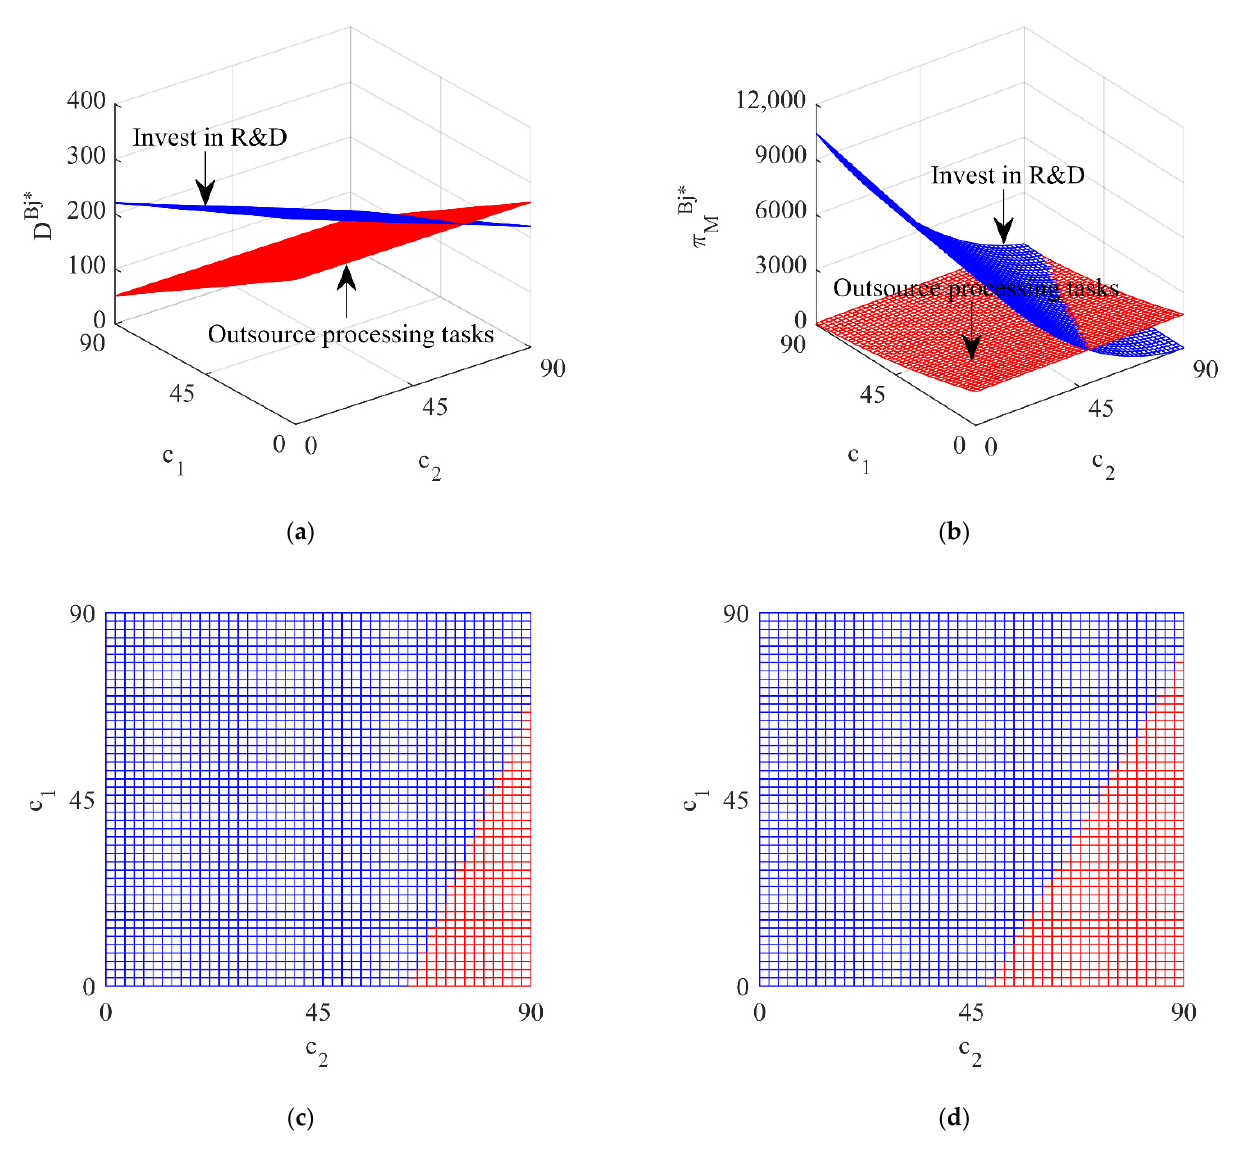
π under subsidizing the ∗ under subsidizing the M M